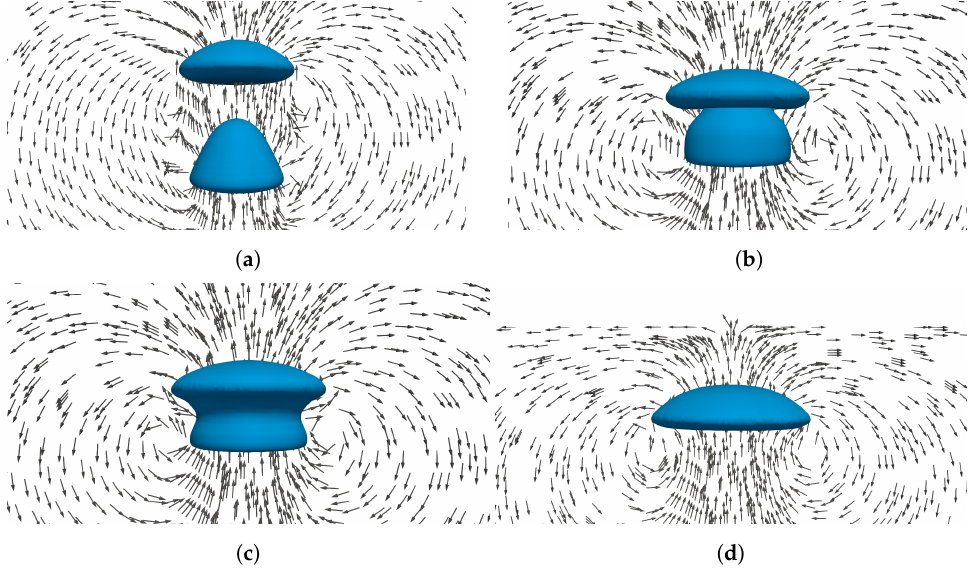
Figure 12. Bubble shapes for the coalescence test represented through the half contour r α = 0.5, with velocity vectors, at four different times: t ∗ = 0.42 ( a ), t ∗ = 0.60 ( b ), t ∗ = 0.63 ( c ) and t ∗ = 0.97 ( d